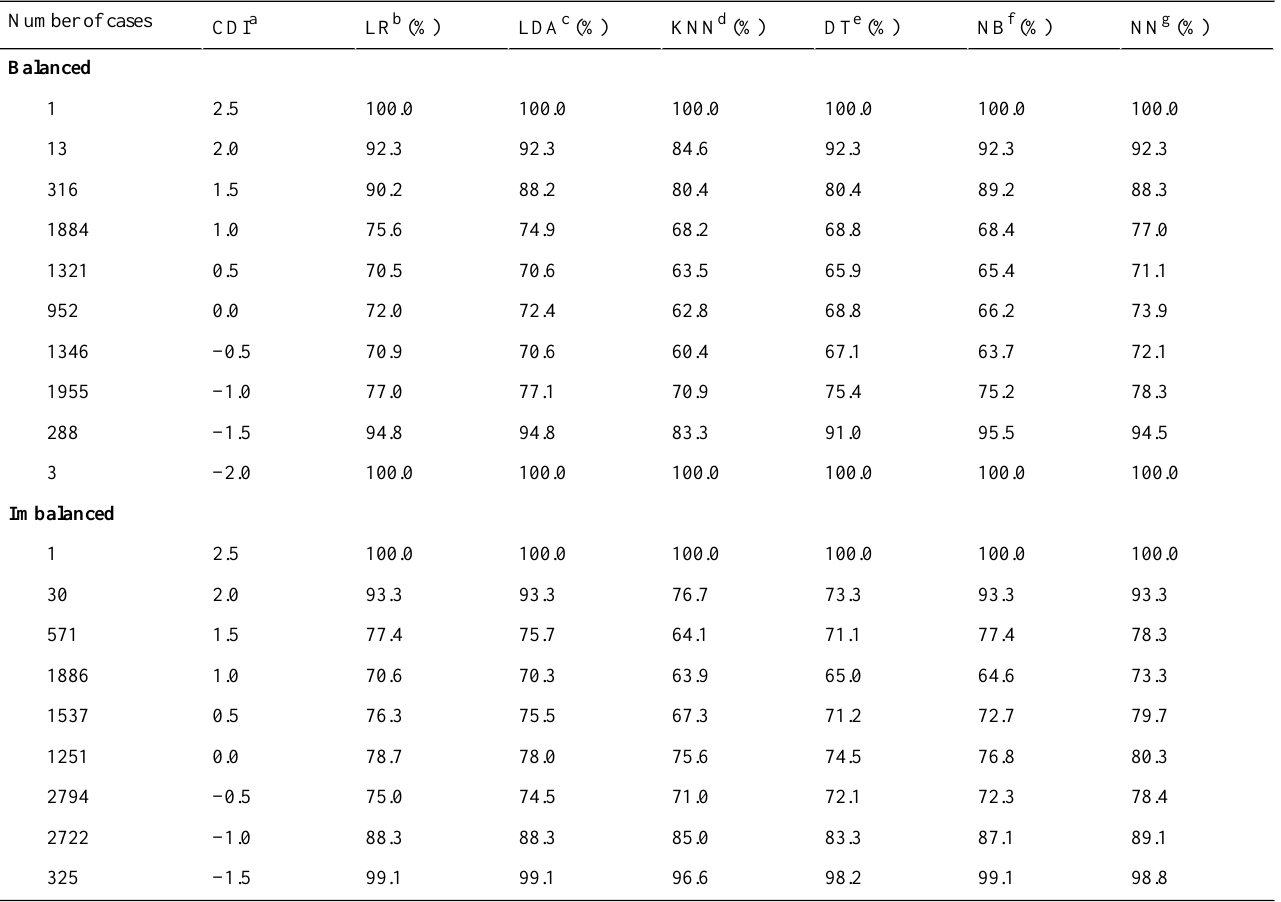
Table 7. Item response theory–based Medical Information Mart for Intensive Care III mortality prediction accuracy stratified by classification difficulty